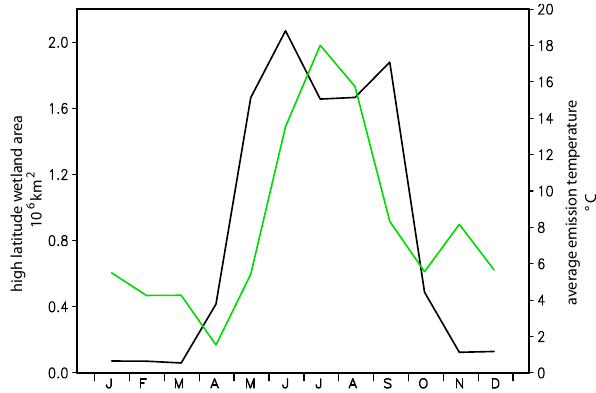
Fig. 2. Seasonal variation of high (55–75 ◦ N) latitude boreal wet- land extent (black line) and emission temperature (defined as the av- erage soil temperature of grid cells emitting CH 4 ; green line) during the